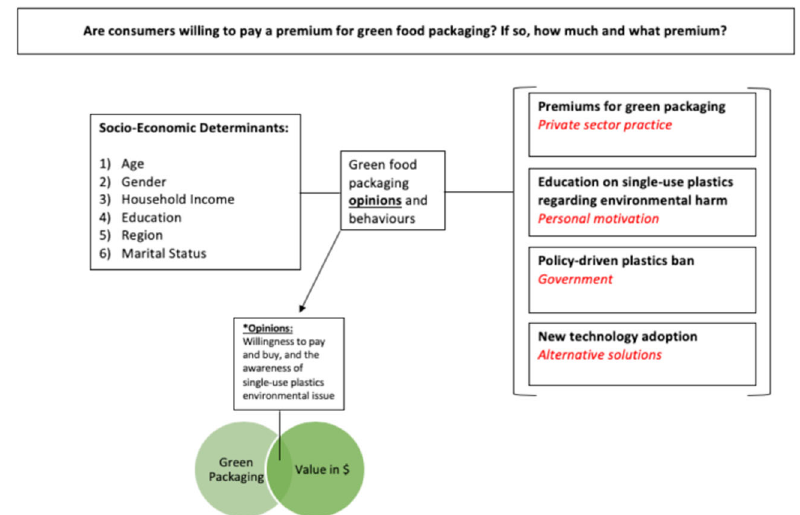
Fig. 1 Conceptual framework of single-use plastic use in the Canadian